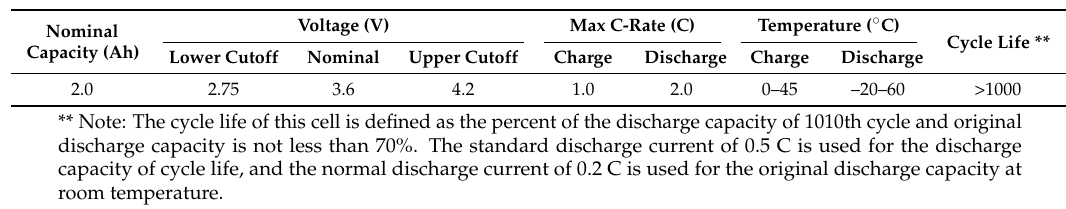
Table 3. Li-ion cell